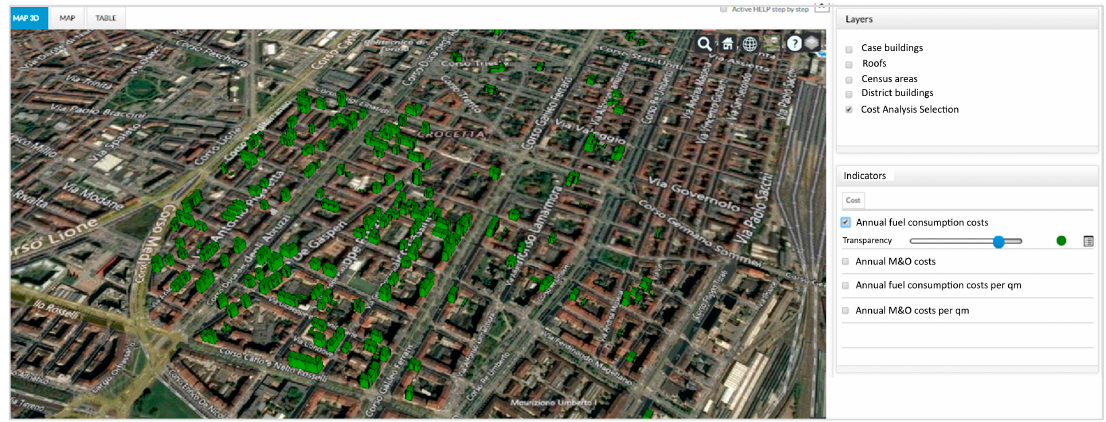
Figure 2. The 200 buildings considered in the Crocetta district geo-referenced on Dashboard.